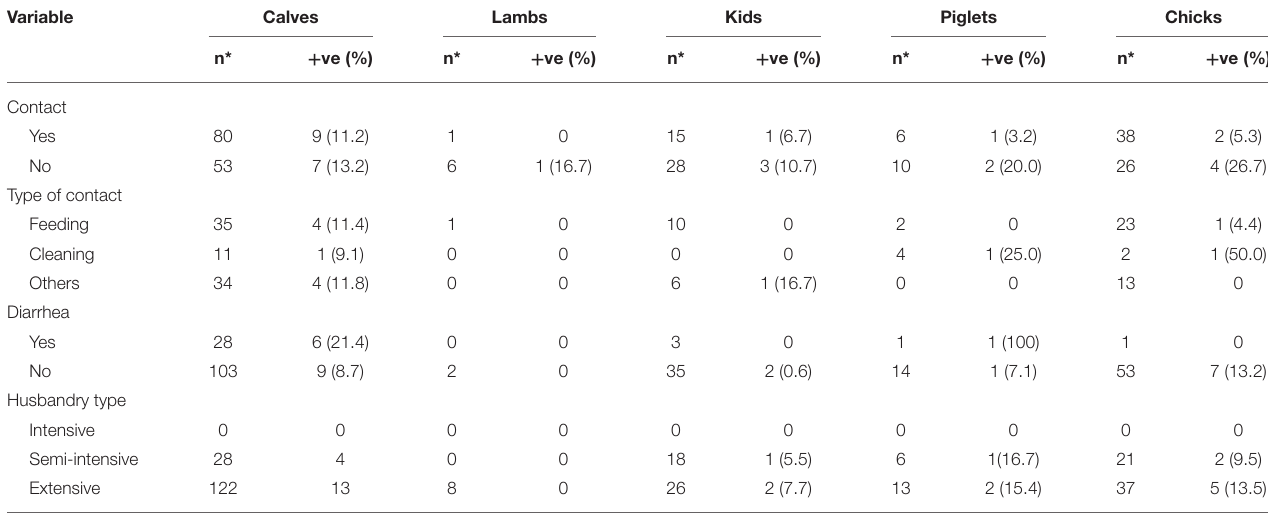
TABLE 3 | Association of Cryptosporidium infection and husbandry practices among adult HIV positive population of Namwala district, Zambia ( n = 326). Variable